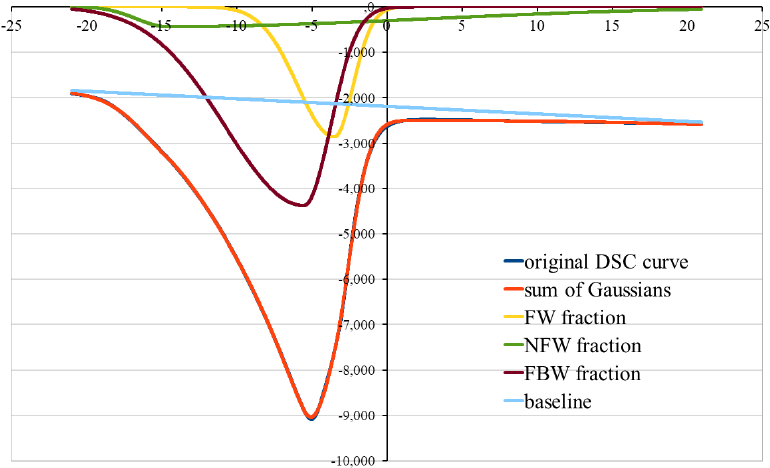
Figure 3. Representative three-component decomposition of the DSC curve, obtained from hydrated raw HPC—W c = 0.92 g/g; dark blue line—original DSC curve overlapped by a red line, that stands for the sum of Gaussians; yellow line—FW fraction of water; green line—NFW fraction of water; brown line—FBW fraction of water; light blue line—baseline.